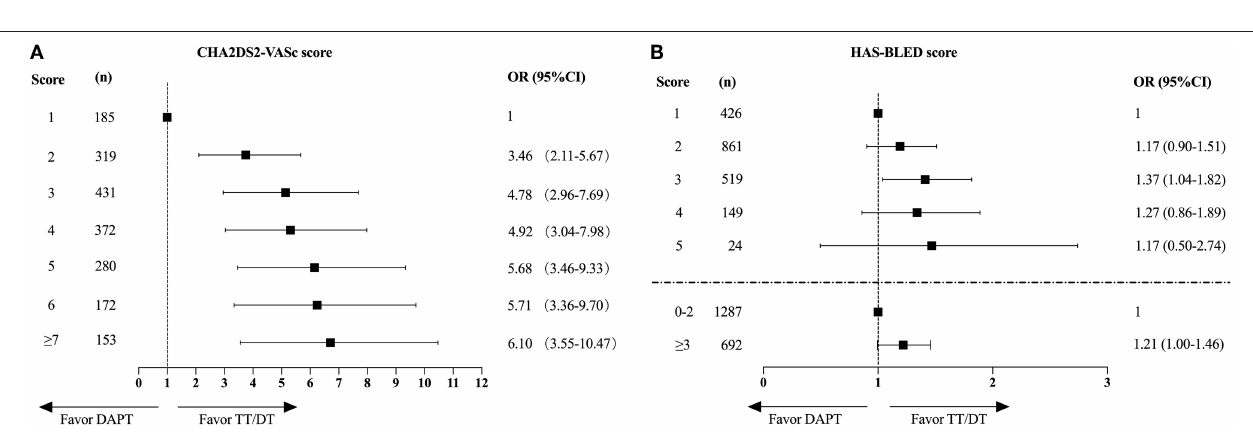
FIGURE 3 | The impact of CHA2DS2-VASc scores (A) or HAS-BLED scores (B) on the choice of antithrombotic therapy. CHA2DS2-VASc score of 1 and HAS-BLED score of 1 served as the reference respectively. OR, odds ratio; CI, confidence interval; DAPT, dual antiplatelet therapy; TT, triple therapy; DT, double therapy.